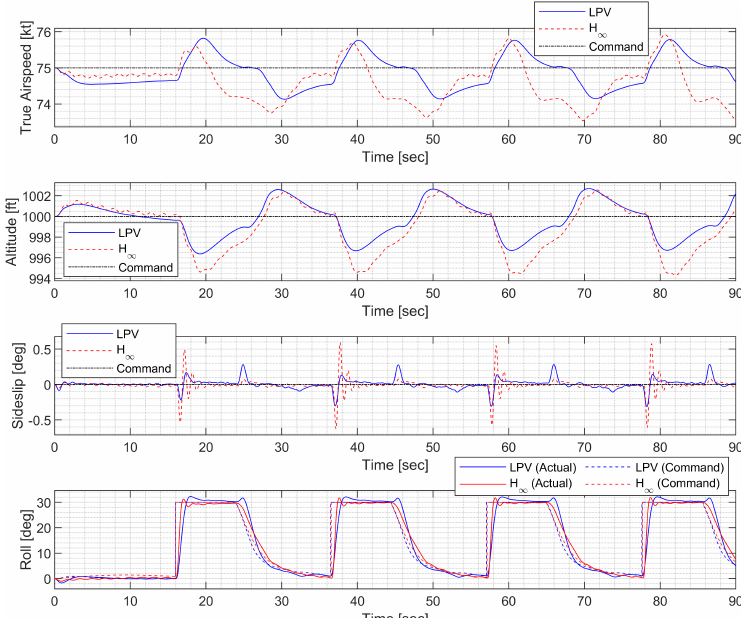
Figure 21. State history of the waypoint-following flight.